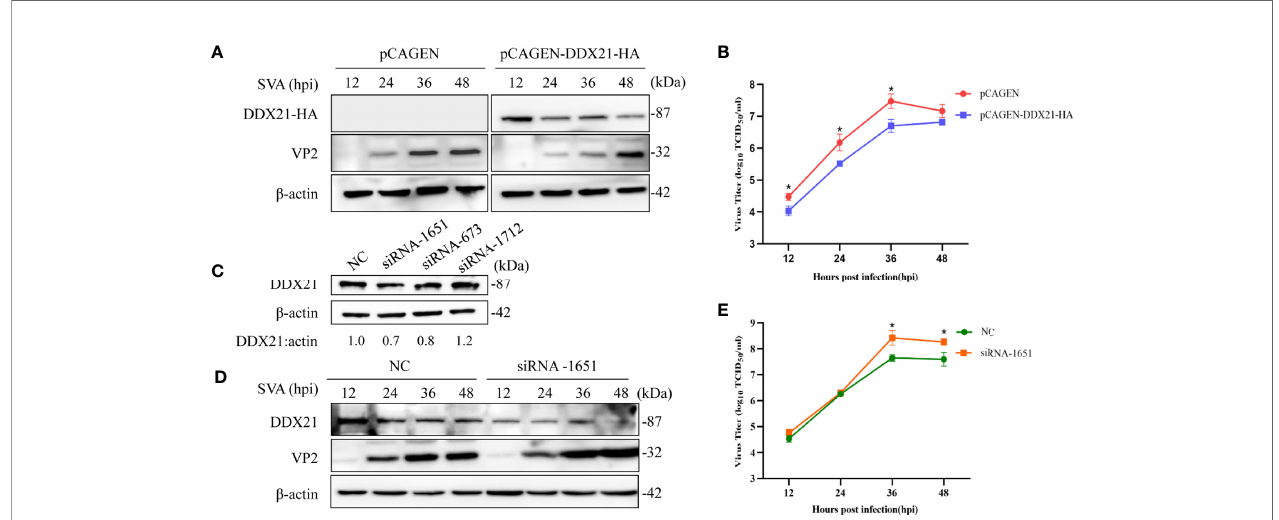
FIGURE 3 | DDX21 affects the replication of SVA. (A) BHK-21 cells were transfected with pCAGEN-DDX21-HA or pCAGEN. At 36 hpt, the cells were inoculated with SVA at an MOI of 0.1. The cells and supernatant were harvested at the indicated times, and the expression level of the VP2 protein of SVA was analyzed by WB with an anti-VP2 pAb. DDX21-HA was detected with an anti-HA mAb. b -Actin served as the internal reference. (B) Virus titers were calculated and expressed as TCID 50 /ml at the indicated times. (C) BHK-21 cells seeded in 6-well plates were transfected with siRNA-1651, siRNA-673, siRNA-1712, or negative control (NC) (50 pM/well). At 36 hpt, the cells were lysed and analyzed by Western blotting (WB) with an anti-DDX21 polyclonal antibody (mAb), and b -actin was probed as the internal reference. (D) Knocking down the expression of DDX21 promoted the replication of SVA in BHK-21 cells. BHK-21 cells were transfected with NC or siRNA- 1651 at 50 pM. At 36 hpt, the cells were infected with SVA at a MOI of 0.1. The cells and the supernatant were harvested at indicated times. The cells were lysed and analyzed by WB using an anti-VP2 pAb. (E) The infectious virus titers in the supernatant were determined by a TCID 50 /ml assay. The statistical signi fi cance of differences was determined using a Student ’ s t -test (NS, not signi fi cant; * p < 0.05).